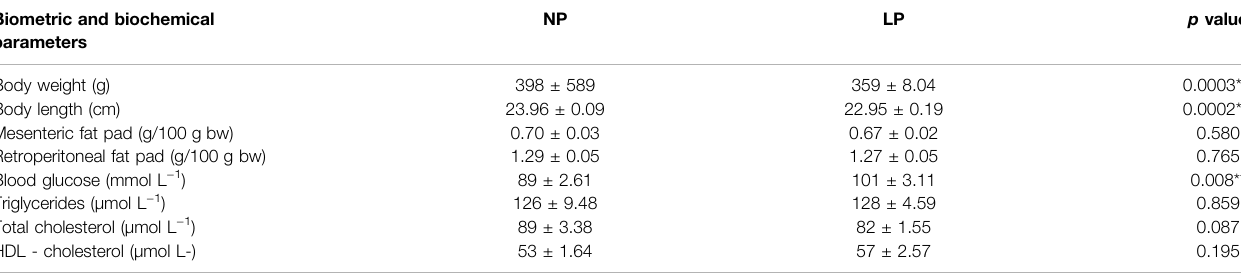
TABLE 3 | Effects of dietary protein restriction in peri-pubertal period on biometric and biochemical parameters. Biometric and biochemical